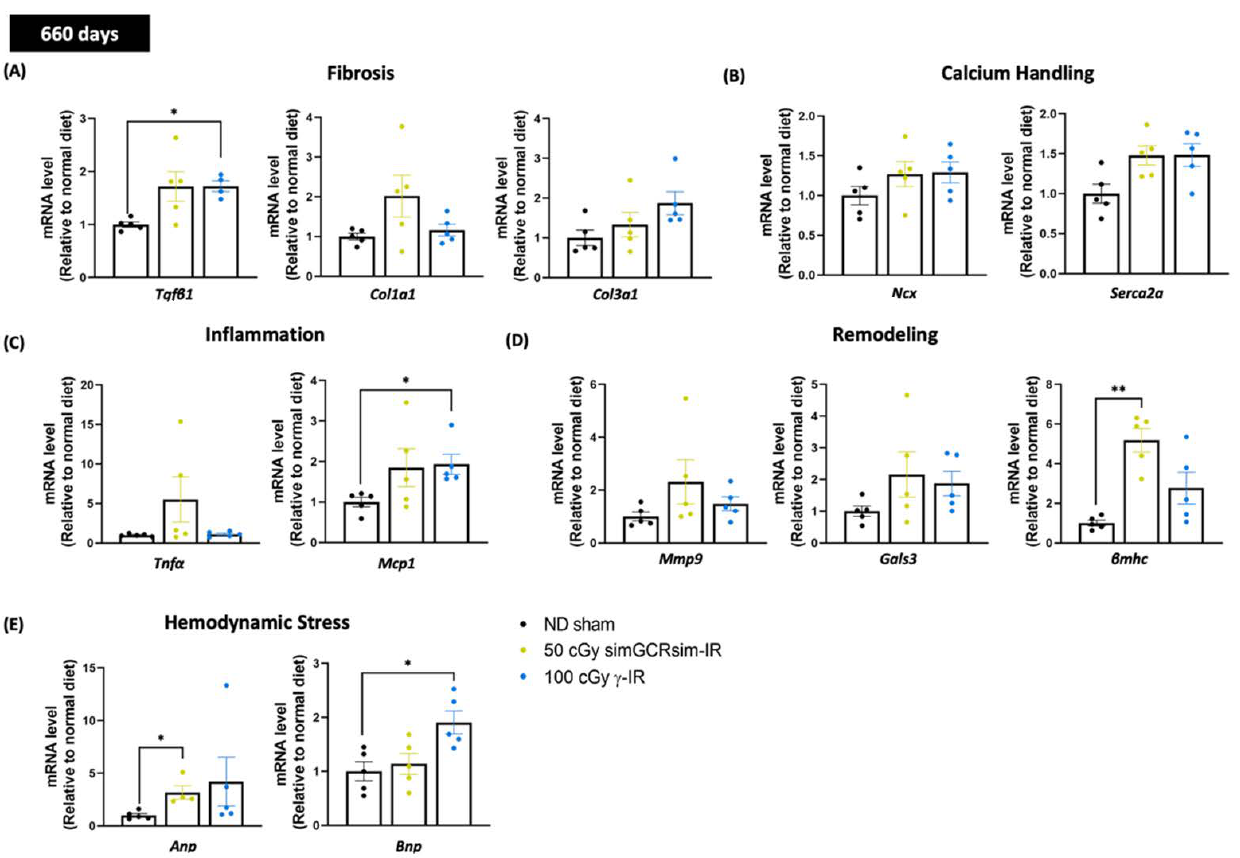
Figure 5. Gene expression in left ventricular tissue was assessed 660 days after simGCRsim and gamma ( γ ) irradiation. Relative mRNA expression of ( A ) cardiac fibrosis ( Tgf β 1 , Col1a1 , and Col3a1 ), ( B ) calcium handling ( Ncx , and Serca2a ), ( C ) inflammation ( TNF α , and MCP1 ), ( D ) cardiac remodeling ( Mmp9 , Gals3 , and β mhc ), and ( E ) hemodynamic stress ( Anp , and Bnp ) markers within the left ventricle (LV) of mice irradiated with 50 cGy simGCRsim or 100 cGy γ at 660 days post-irradiation. Tgf β 1 indicates transforming growth factor beta 1; Col1a1 , type I fibrillar collagen; Col3a , type III fibrillar collagen; Ncx , cardiac sodium-calcium exchanger; Serca2a , Sarcoplasmic Reticulum Ca 2+ ATPase; Tnf α , tumor necrosis factor alpha; Mcp1 , monocyte chemoattractant protein-1; Mmp9 , matrix metalloproteinase-9; Gals3 , galectin 3; β mhc , cardiac beta myosin heavy chain; Anp , atrial natriuretic peptide; Bnp , brain natriuretic peptide. Each dot represents an individual mouse. Expression was normalized to GAPDH . Data reported as mean ± SEM. n = 5 animals/treatment group; p -values were calculated using Kruskal-Wallis H test, ** p < 0.01, * p <